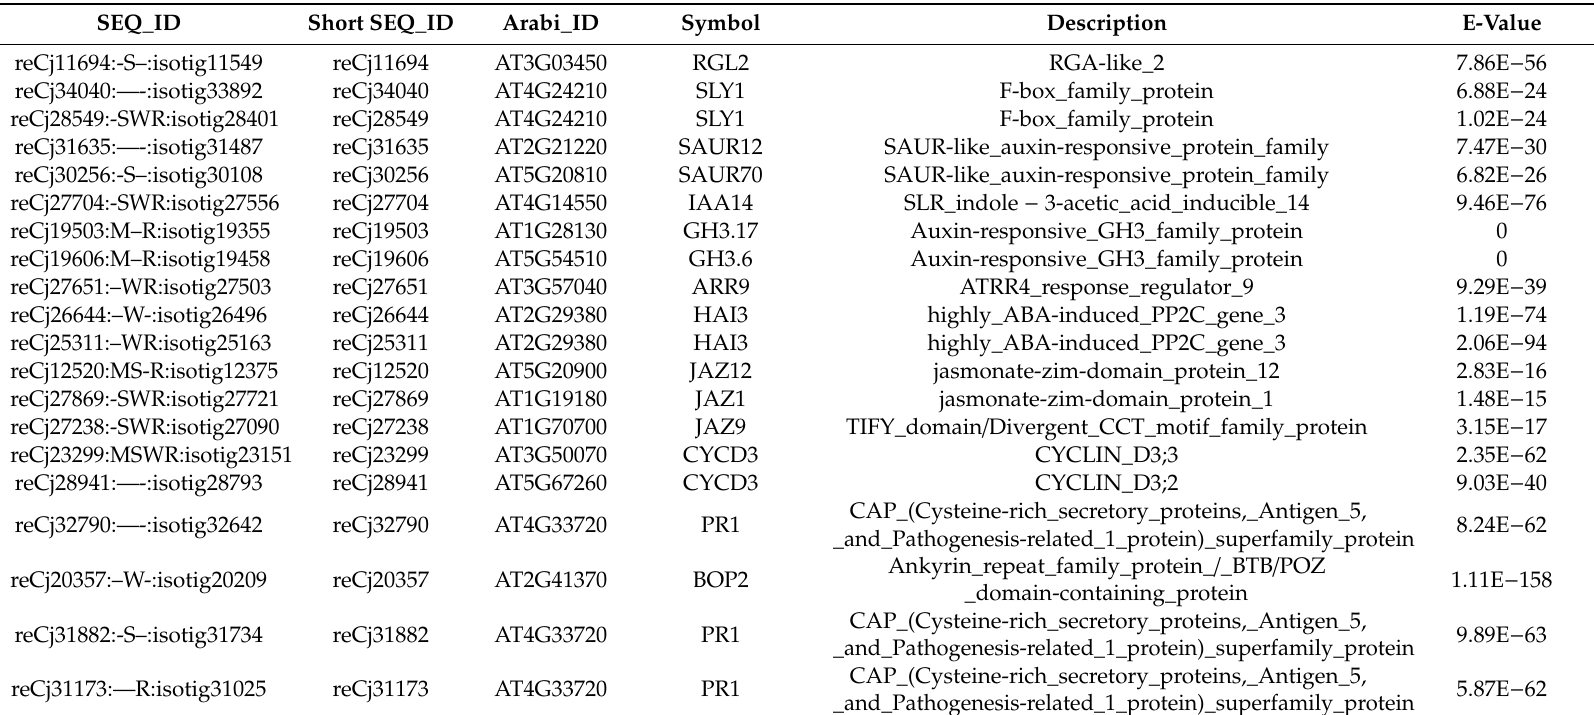
Table 1. The DEGs associated with plant hormone signaling pathways after GA 3